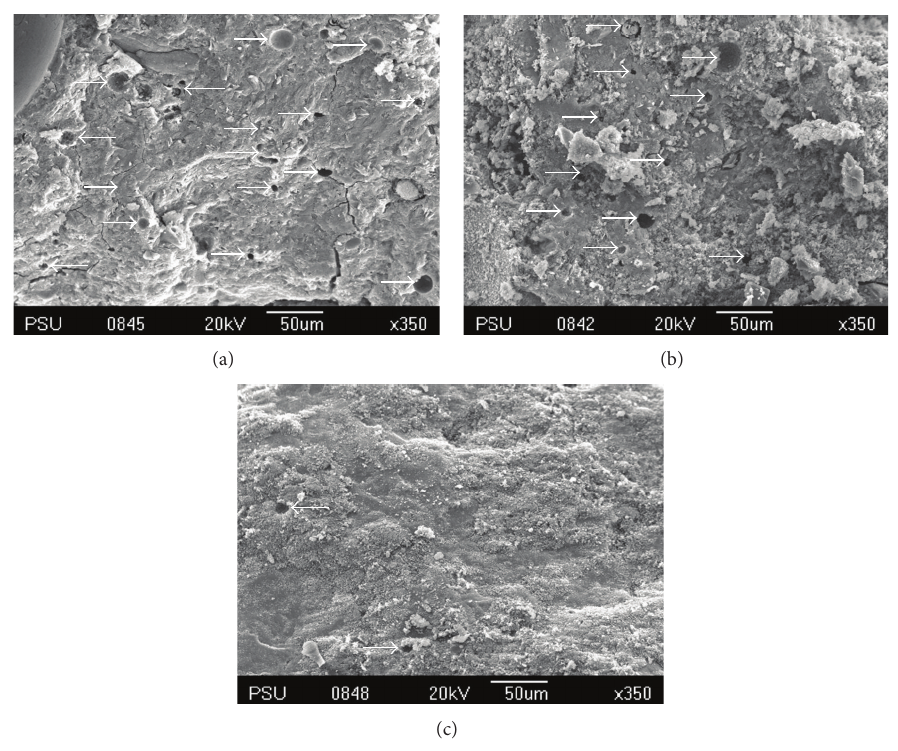
Figure 9: SEM micrograph of geopolymer mortar; (a) O15-1, (b) O15-2, and (c) O15-4.